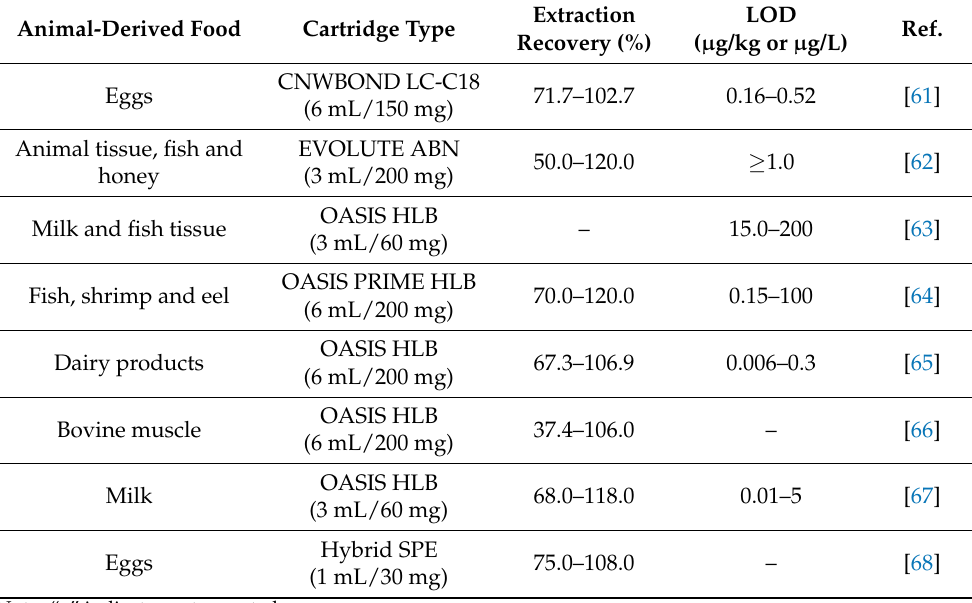
Table 1. Comparison of the efficacy of different cartridges for veterinary drugs in animal-derived foods. Animal-Derived